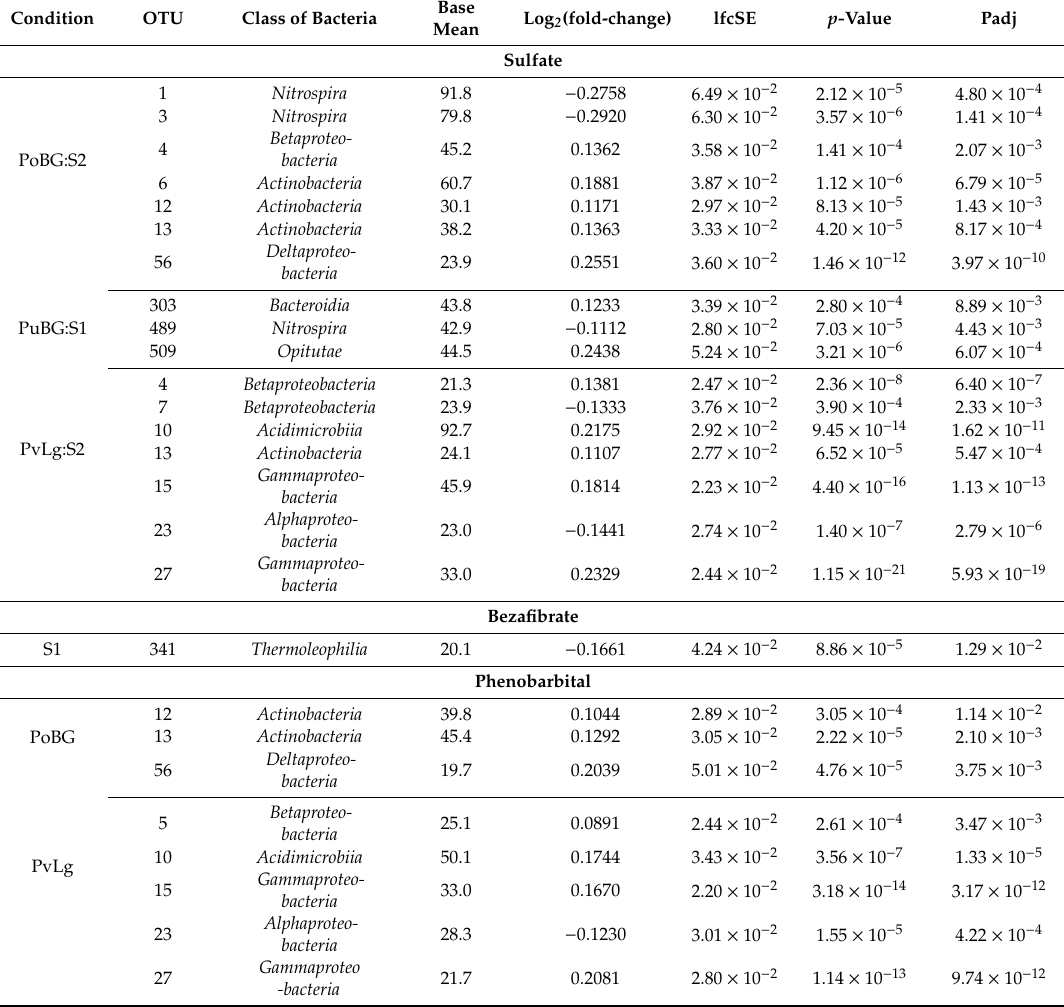
Table 4. E ff ect size and significance of sulfate within location and season, and phenobarbital within the location for individual OTUs. The condition is shown where levels for variables were grouped and were significant. The Identifier (ID) of the OTU and the class of bacteria is given; base mean: mean of the occurred OTUs in the library; log 2 (fold-change): size-factor normalized OTU counts; lfcSE: log 2 (fold-change) standard error; p -value: adjusted p -value; padj: false discovery rate (Benjamini–Hochberg adjusted p